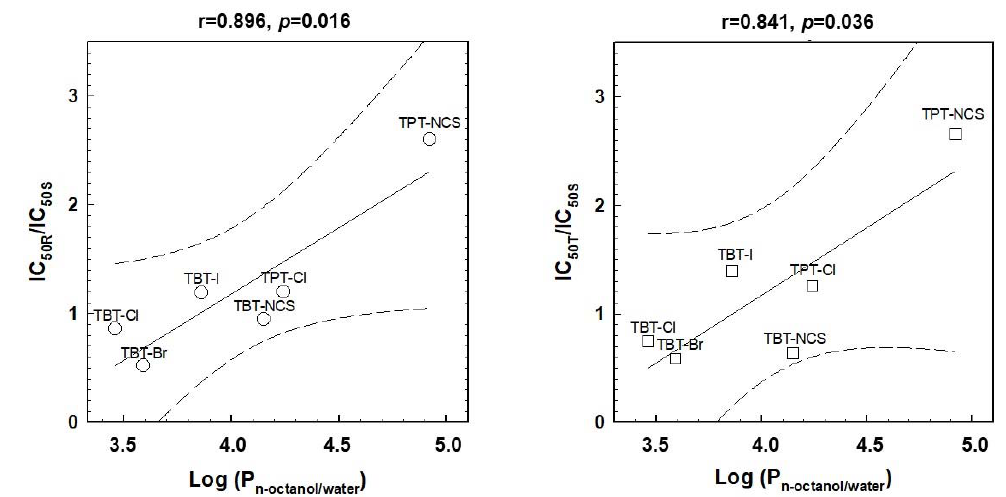
Figure 6. The correlations between the ratios of the IC 50 values (from Table 1) obtained for either R versus S cells (IC 50R /IC 50S ) or T versus S cells (IC 50T /IC 50S ) and log P are documented in Table 1. Linear regressions were calculated using SigmaPlot graphing software (version 8.00, Systat Software GmbH, Erkrath, Germany). The p —two-tailed probability were calculated for the corresponding r—correlation coefficient and a sample size of 6 using the online p -value Calculator for Correlation Coefficients similarly to that described in Table 3. Lines: — regression line; - - - - confidence interval (level 0.99).